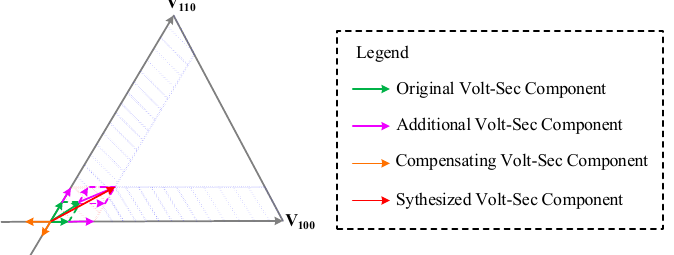
Figure 11. Space vector allocation with duty ratio adjustment and switching state compensation.